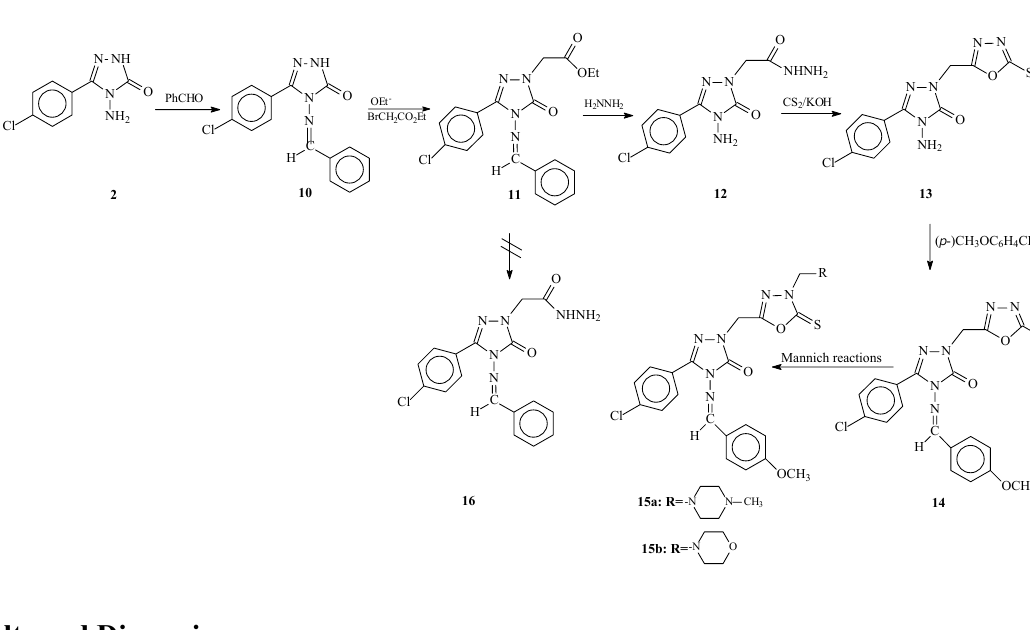
Scheme 2. The synthetic routes for compounds 10–15